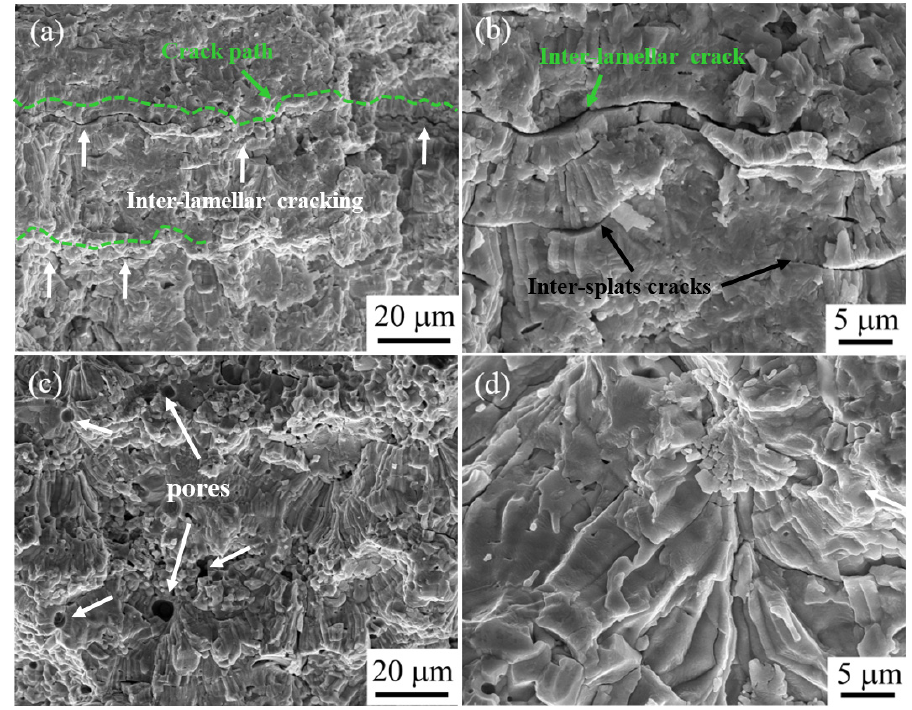
Figure 6. Typical fracture morphologies of the coating after failure at different magnifications: ( a , b ) 15–25 μ m; and ( c , d ) 45–60 μ m.